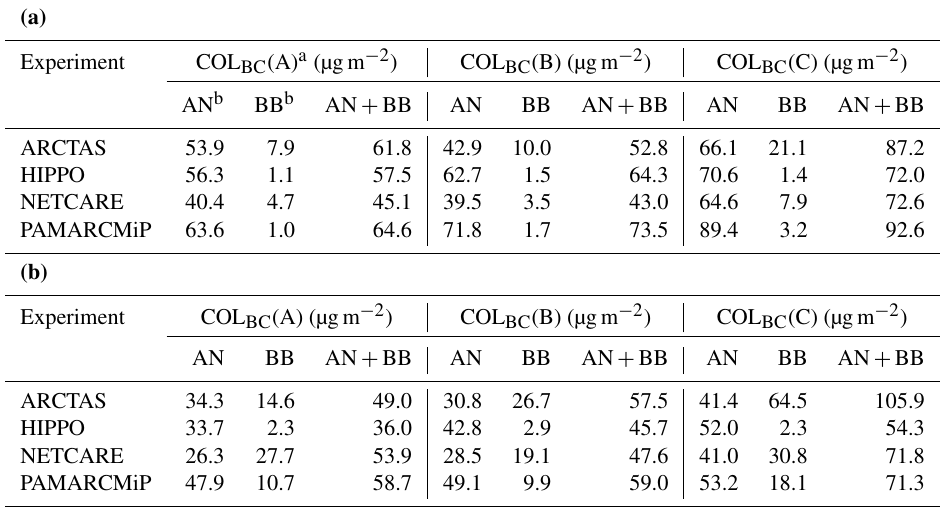
Table 5. (a) Model-calculated column BC amounts with the CAM5-ATRAS model. (b) Model-calculated column BC amounts with the MRI-ESM2